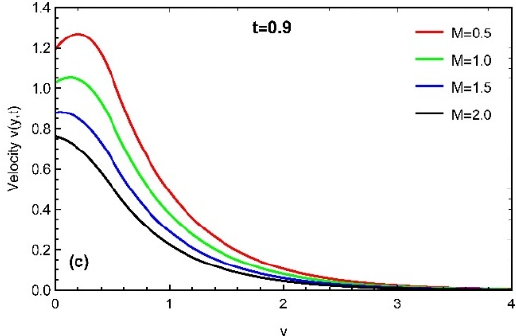
Figure 12. Variation in momentum field due to magnetic field with α = β = γ = 0.7, Pr ef f = 1.4, Sc ef f = 1.1, Gr = 0.75, Gm = 0.5, Re = 1.3, θ 1 = θ 2 = π ( a ) t = 0.5 ( b ) t = 0.7 ( c ) t = 0.9.